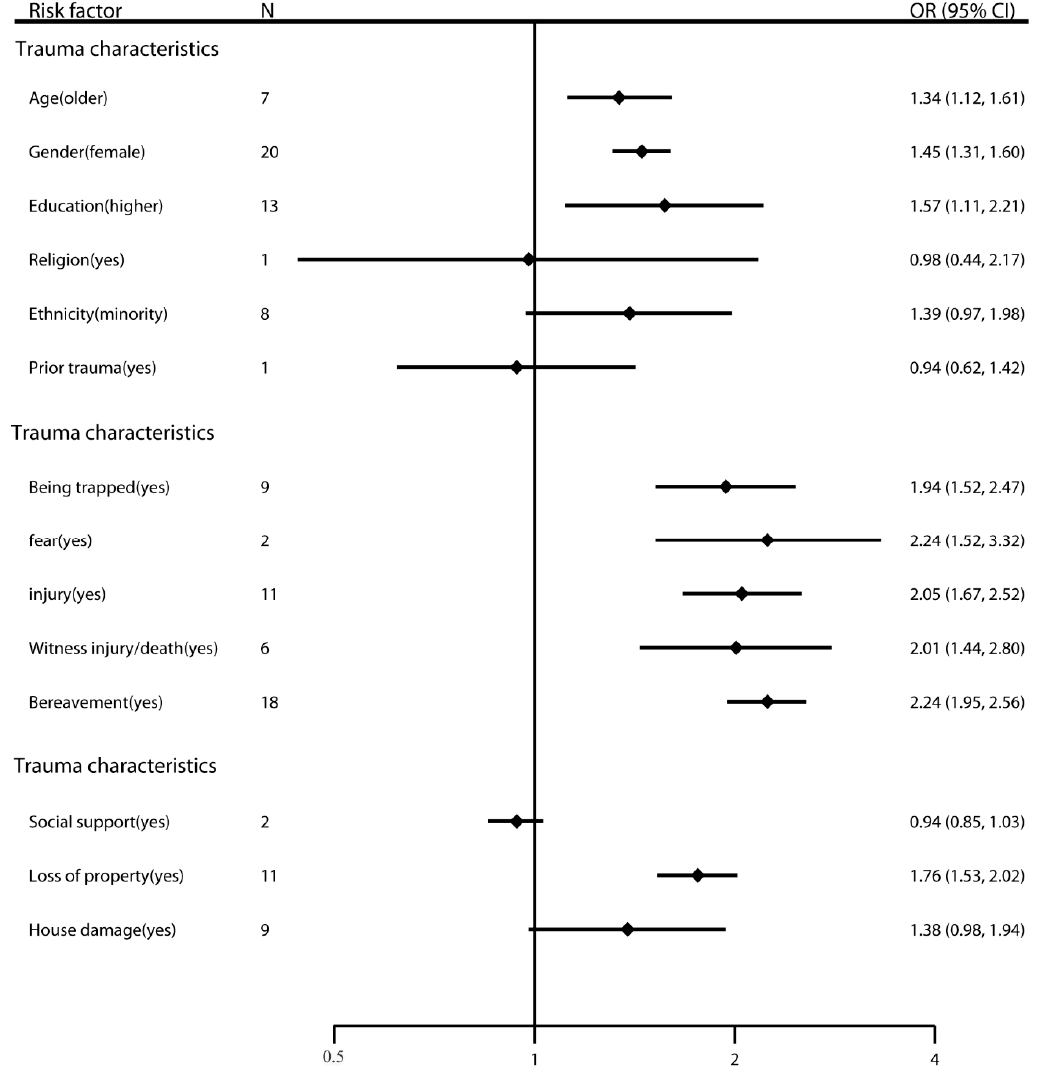
Figure 3. Risk factors for PTSD after earthquake in children.